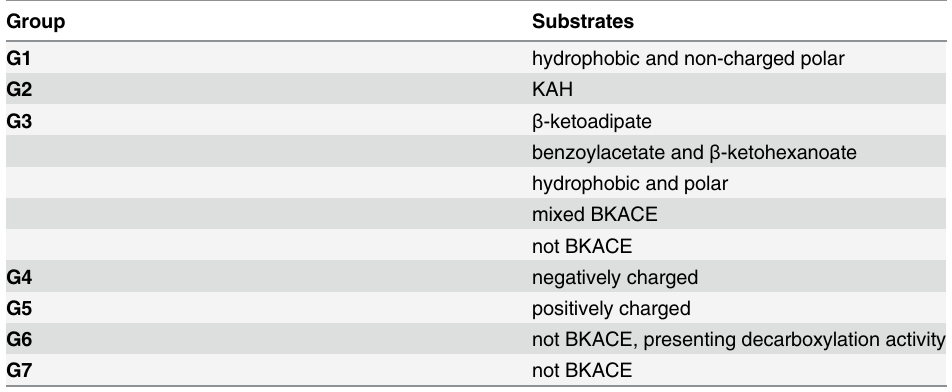
Table 7. Substrate nature in each